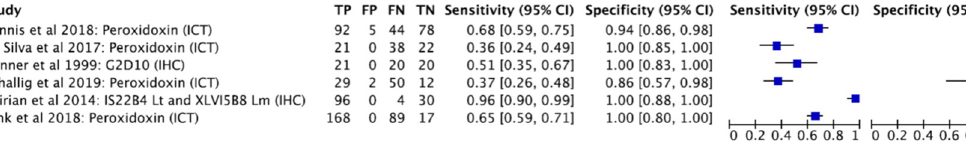
Fig 4. Forest plot representing sensitivity and specificity indices of other immunological tests using different antigenic targets for